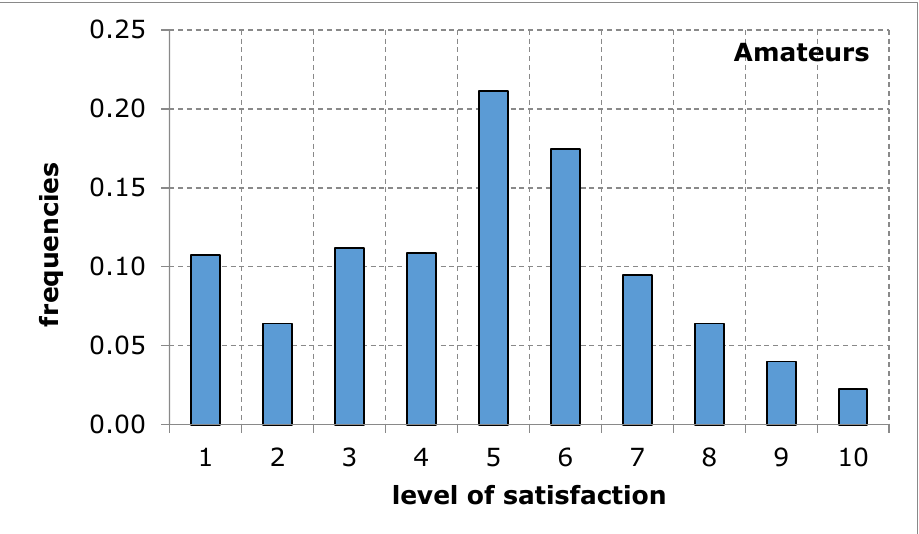
Figure 11. Lack of preferred sport and recreational activities at a sports and recreation facility, in the opinion of service recipients (amateurs). Source: own work.